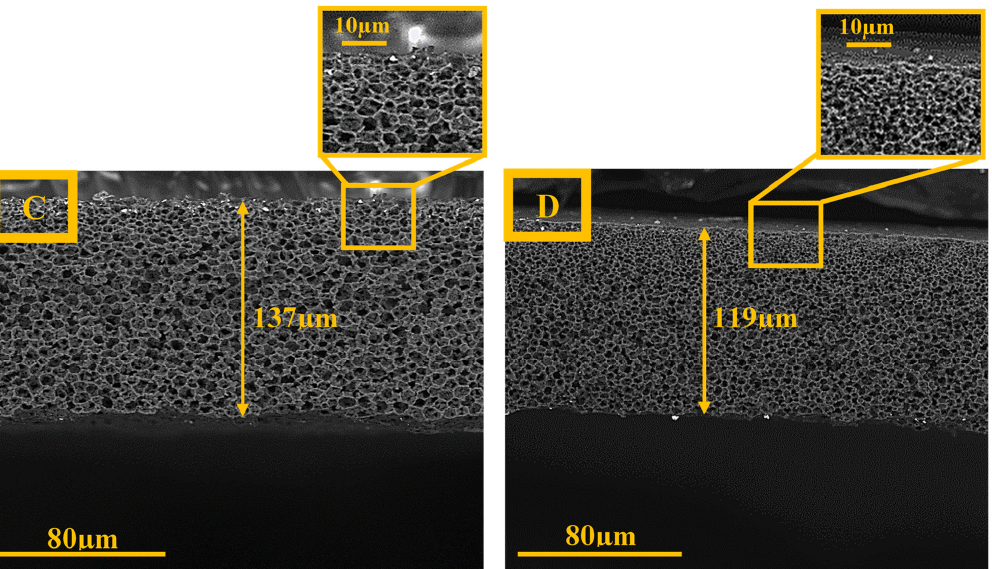
Figure 6. The cross-section SEM images (1000×) for PA6 membranes with different gelation times: ( A )—0 min; ( B )—2 min: ( C )—4 min, and ( D )—10 min. ( A )—0 min; ( B )—2 min: ( C )—4 min, and ( D )—10 min.